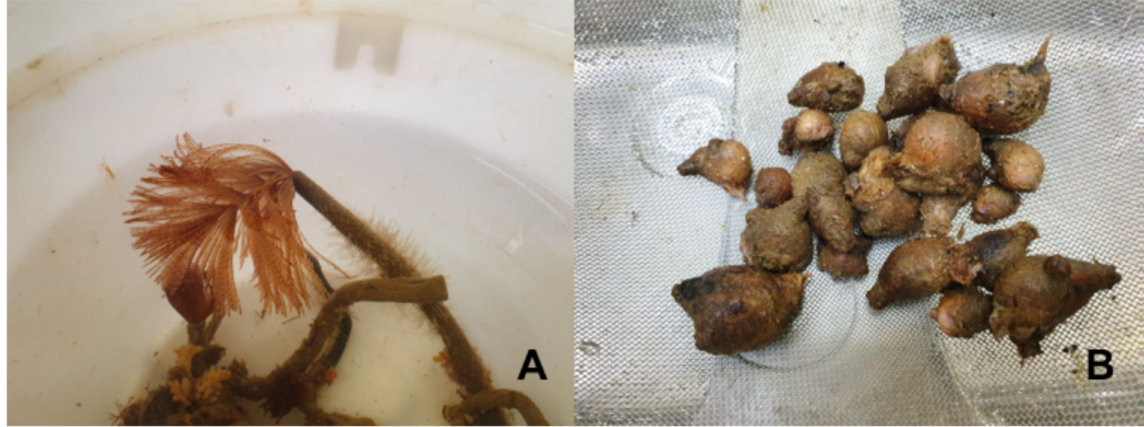
Figure 1. Collected specimens of Sabella spallanzanii ( A ) and Microcosmus squamiger ( B ). (Photo by Yu